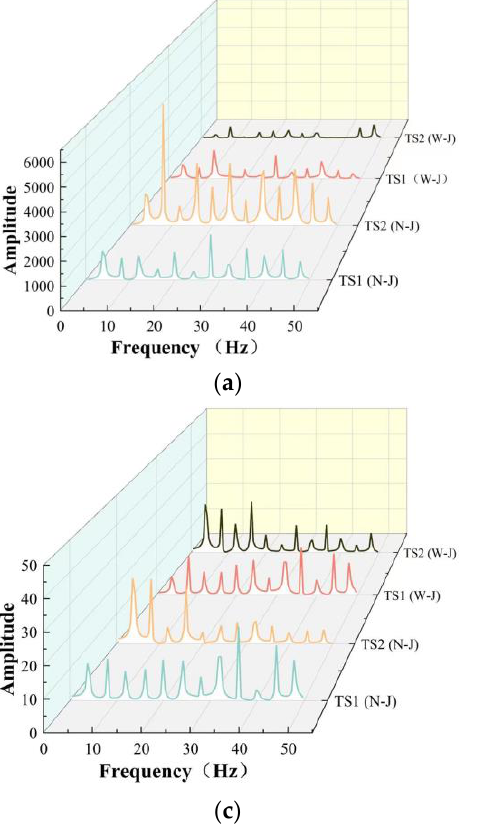
Figure 14. Pressure pulsation spectrum at monitoring points TS1 and TS2 under four operating conditions. ( a ) Q* = 53%, ( b ) Q* = 69%, ( c ) Q* = 84%, ( d ) Q* = 100%.